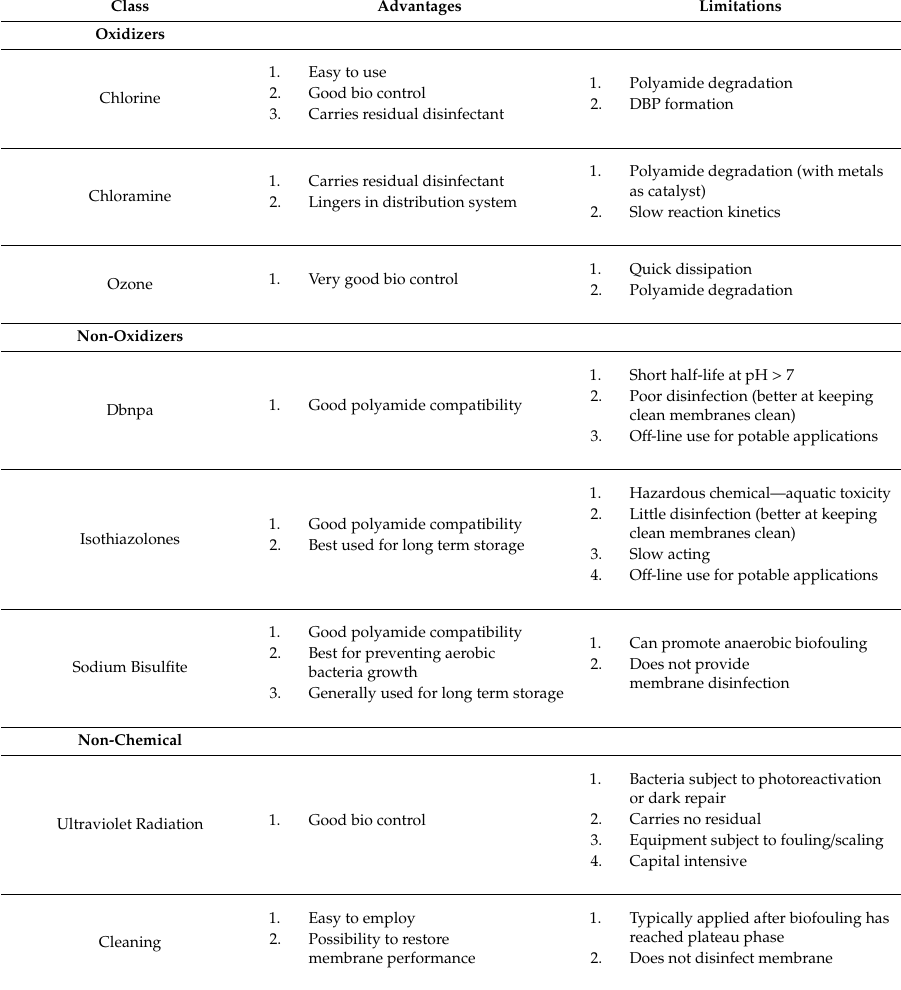
Table 20. Summary of the salient advantages and limitations of currently employed, conventional biofouling control techniques for polyamide membrane